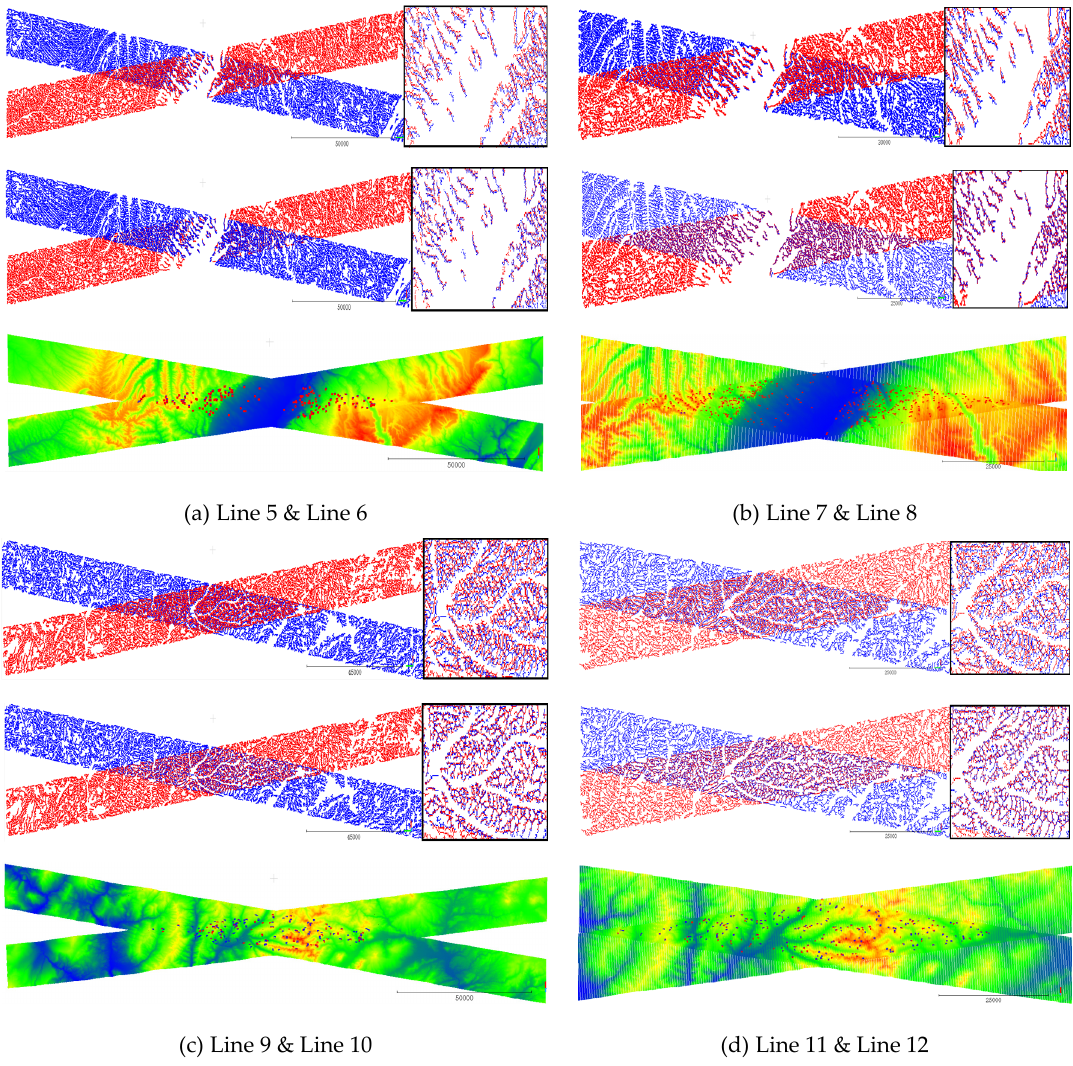
Figure 10. Registration results with di ff erent overlapping rates, topography and noise. From the top to bottom are the original ridgelines, registered ridgelines and correspondences